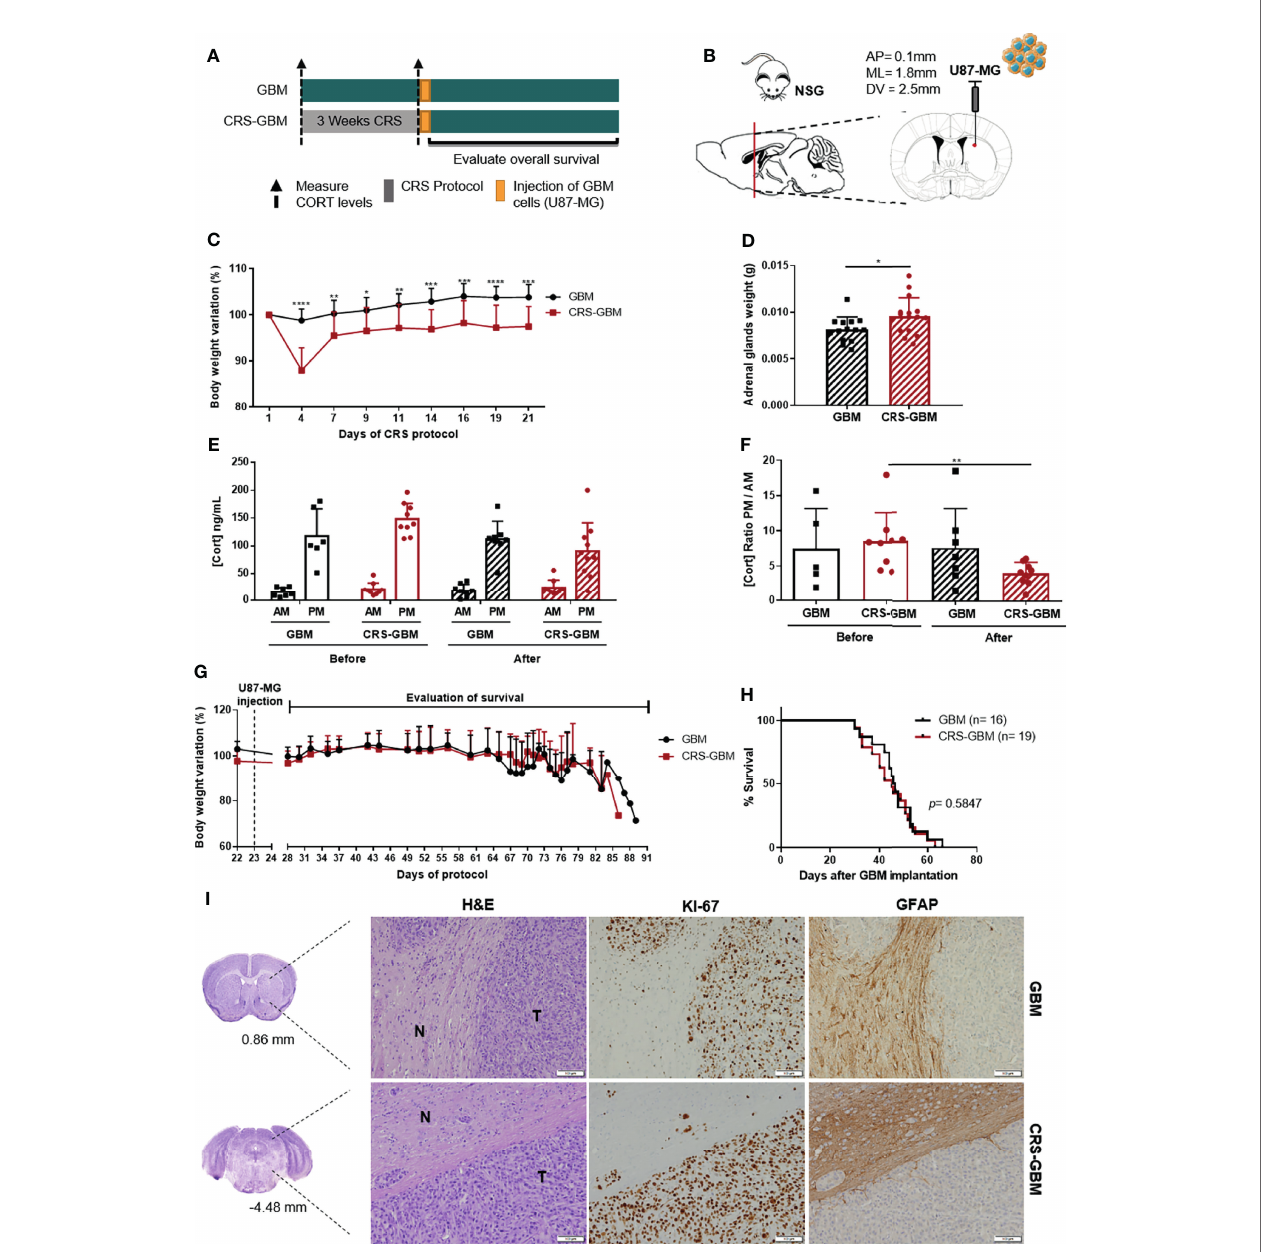
FIGURE 2 | Chronic restraint stress does not affect overall survival in an immunocompromised xenograft model of GBM. (A) Experimental Design. NSG mice were subjected to 3 weeks of CRS (CRS-GBM group) or regular handling (GBM group) before the orthotopic injection of a human GBM cell line, U87-MG, followed by the evaluation of mice body weight and overall survival. (B) Sagittal and coronal representation of the stereotactic injection site of U87-MG cells into the mouse brain with the following coordinates from bregma (AP = 0.1 mm; ML = 1.8 mm; DV = 2.5 mm). (C) Body weight variation percentage from initial weight of GBM (black; n = 13) and CRS-GBM (red; n = 14) groups during CRS protocol representative of the two independent experiments. (D) Adrenal glands weight upon sacri fi ce of animals (GBM, n = 16; CRS-GBM, n = 19). (E) Serum CORT levels of GBM and CRS-GBM groups from morning (AM) and evening (PM) blood collections before and after the CRS protocol (GBM, n = 7; CRS-GBM, n = 9). (F) Ratio of evening (PM) per morning (AM) CORT circulating levels of GBM and CRS-GBM groups before and after the CRS protocol (GBM, n = 7; CRS-GBM, n = 9). (G) Body weight variation percentage from initial weight of GBM (black; n = 13) and CRS-GBM (red; n = 14) group after orthotopic injection of U87-MG GBM cells representative of the two independent experiments. (H) Kaplan – Meier survival curves of GBM (black, n = 16) and CRS-GBM (red, n = 19) groups in U87-MG glioma-bearing mice. (I) Representative coronal sections of the mouse brain area (GBM at 0.86 mm and CRS-GBM at -4.48 mm from bregma). Hematoxylin-eosin staining of mice brains presenting a tumor area (T) and surrounding non-tumor brain tissue (N). Immunohistochemical staining for Ki67 and GFAP of mice brains orthotopically-injected with U87-MG cells of GBM group and CRS-GBM group. Magni fi cation of 100x (Scale= 100 m m). *p < 0.05; ** p < 0.01; *** p < 0.001; **** p < 0.0001. Data from two independent in vivo